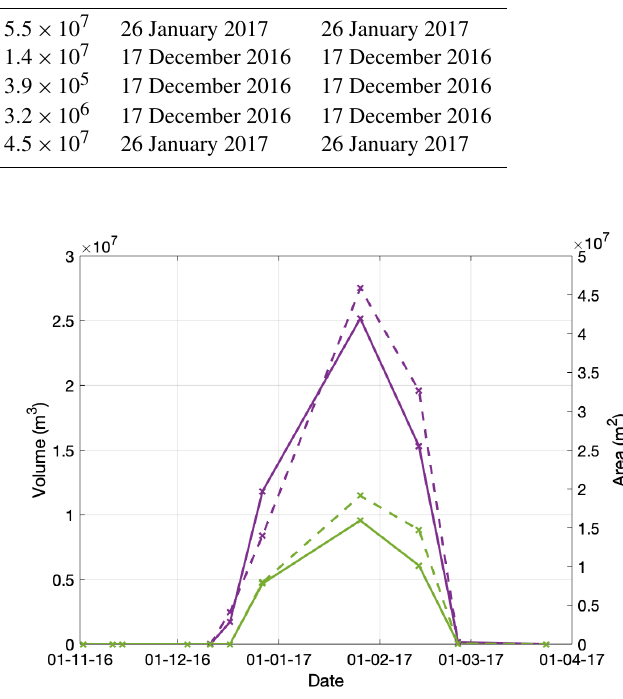
Figure 8. Time series showing the area (dashed line) and volume (solid line) of the WS (purple) and ES